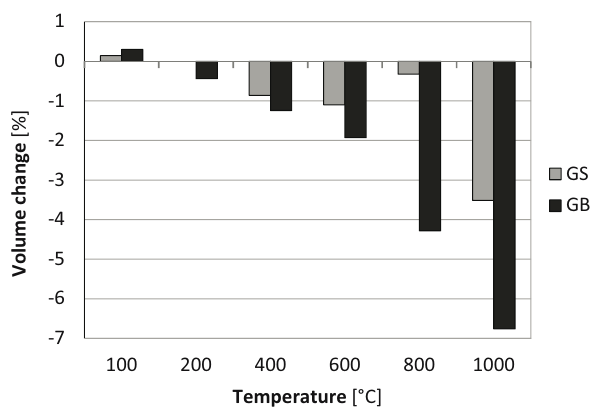
Figure 12: Volume changes of both composites after exposition to high